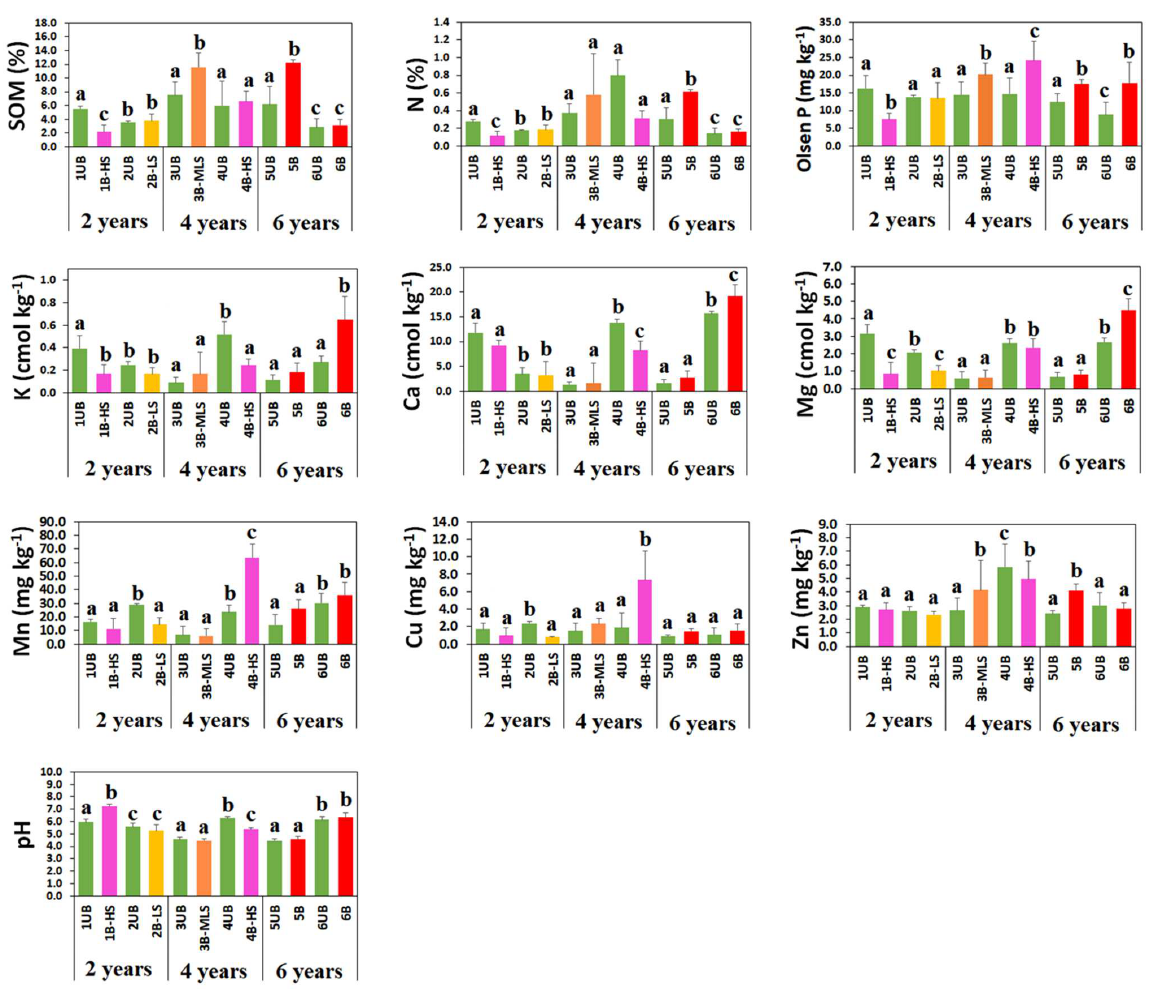
Figure 5. Effects of wildfires on organic matter (SOM), total N, P, K, Ca, Mg, Mn, Cu, Zn, and pH of the soils of the HMs of southern Ecuador. Results are presented for unburned areas (UB) with their respective burned area (B) two (2019), four (2017), and six (2015) years after the fire. Furthermore, the degree of severity of each of the burned areas is presented. Bars stand for the standard error. Different letters mean significant difference among burning scenarios within each study year ( p < 0.05, Tukey